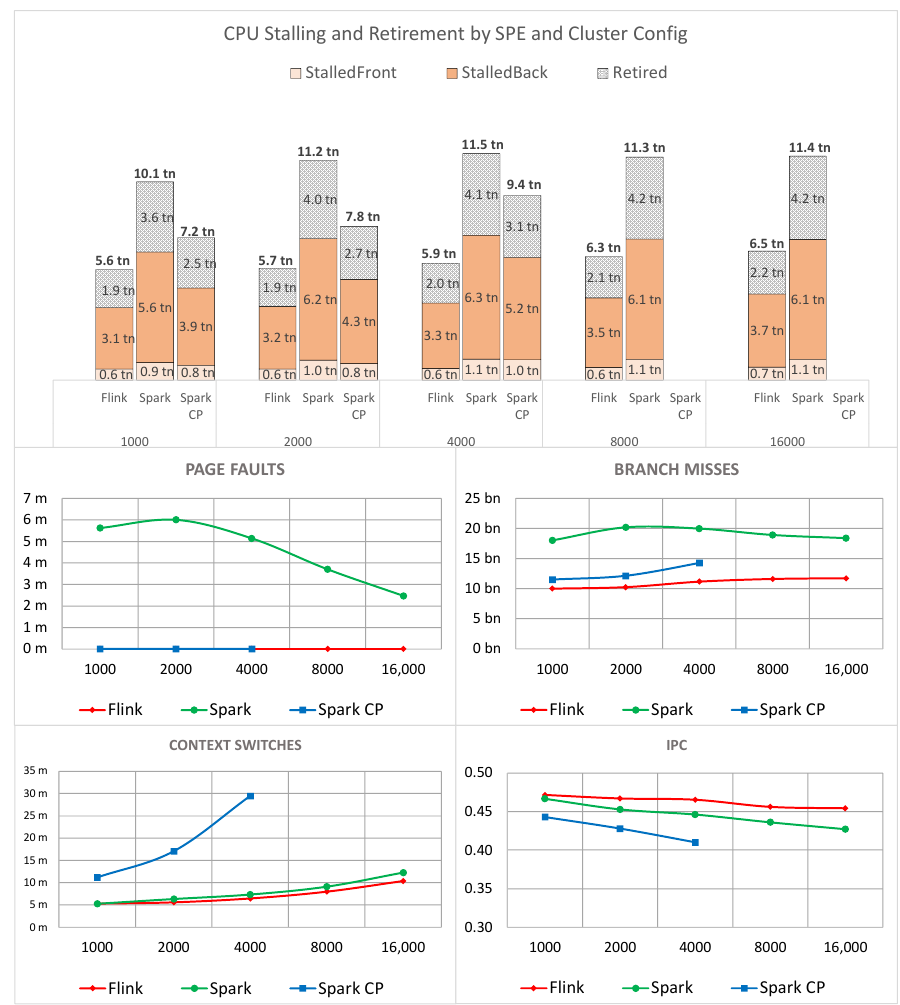
Figure 16. CPU stalling behavior when scaling campaigns from 1k to